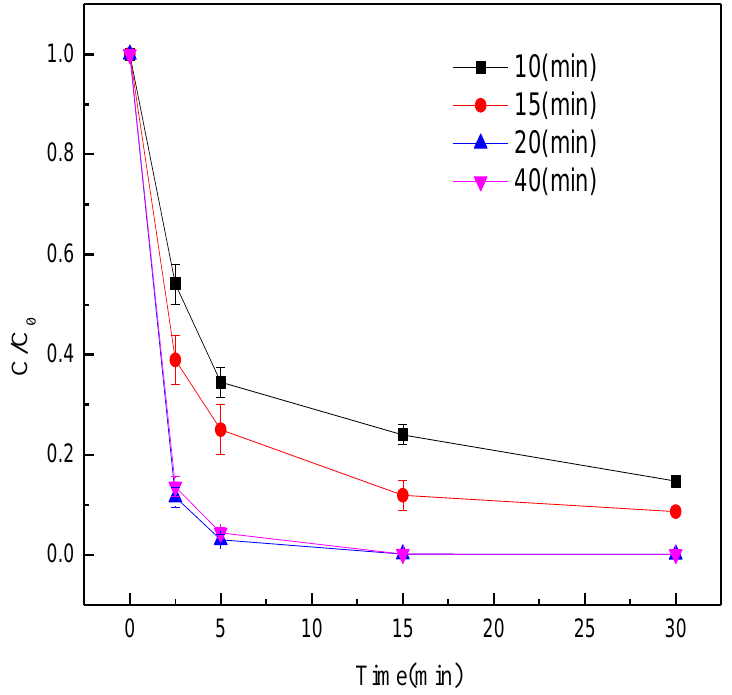
Figure 4. Effects of calcination time on the decolorization efficiency of methyl orange.